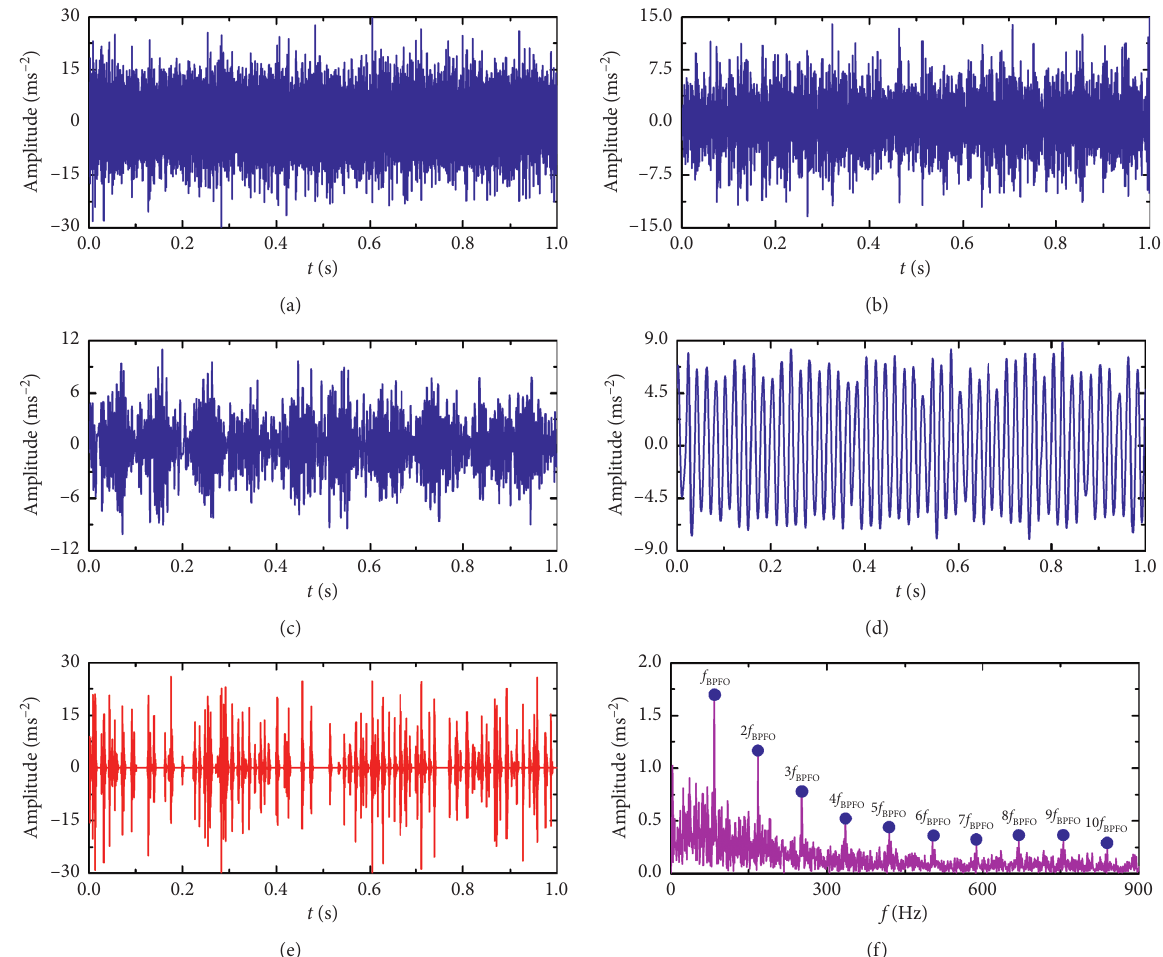
Figure 13: Results obtained by the proposed ALIF-SBAKW: (a–d) IMF1-IMF4, (e) extracted signal, and (f) Hilbert envelope spectrum of signal in (e).